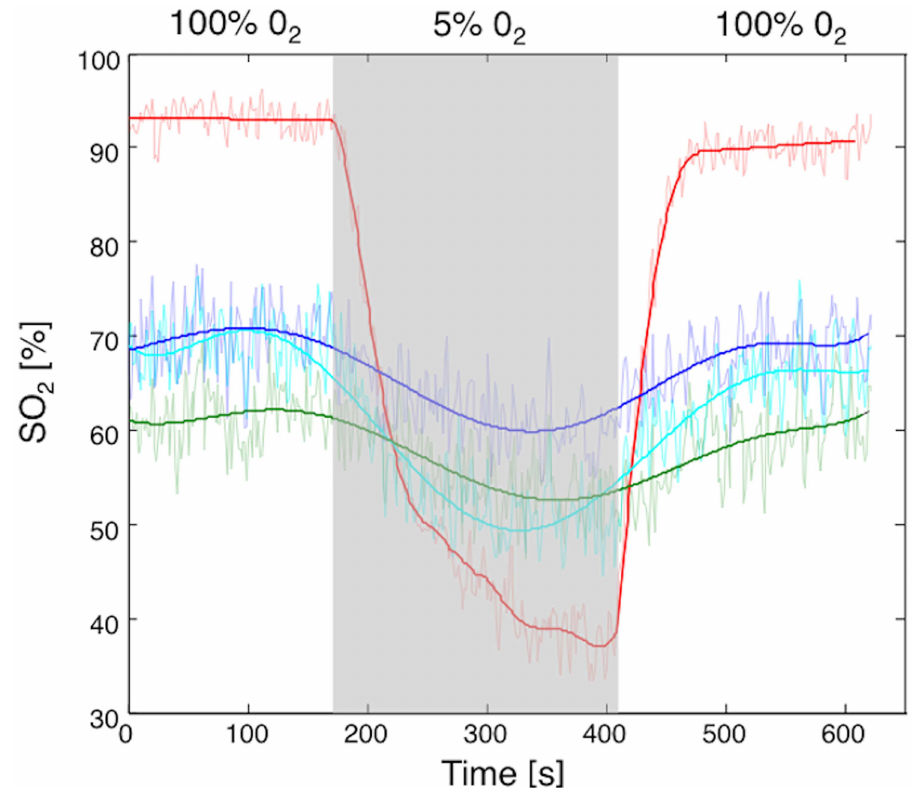
Fig 3. Time-intensity curves obtained during the experimental sequence of hyperoxygenation (100% oxygen, 2.5 min), hypoxia (5% oxygen, 4 min), and hyperoxygenation (100% oxygen, 4 min) from skin (red), mesometrial triangle (light blue), basal zone (green), and labyrinth zone (dark blue) on day 20 of